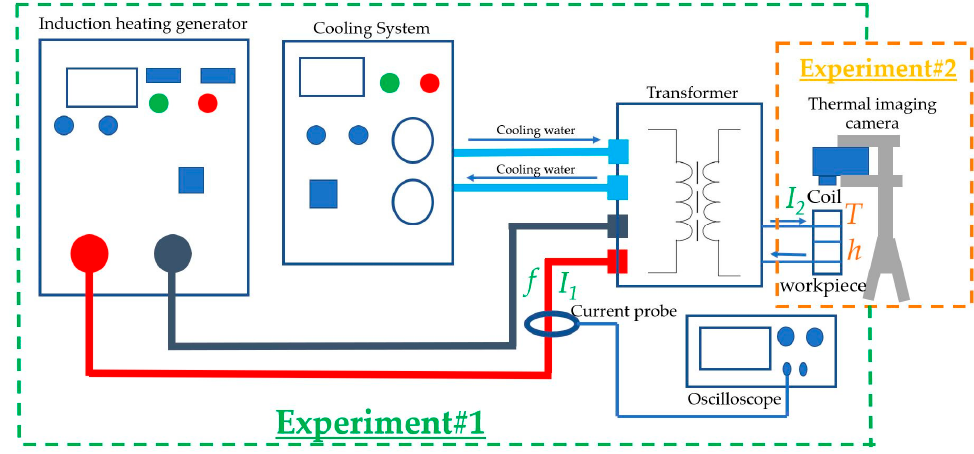
Figure 6. A diagram of two experiments.